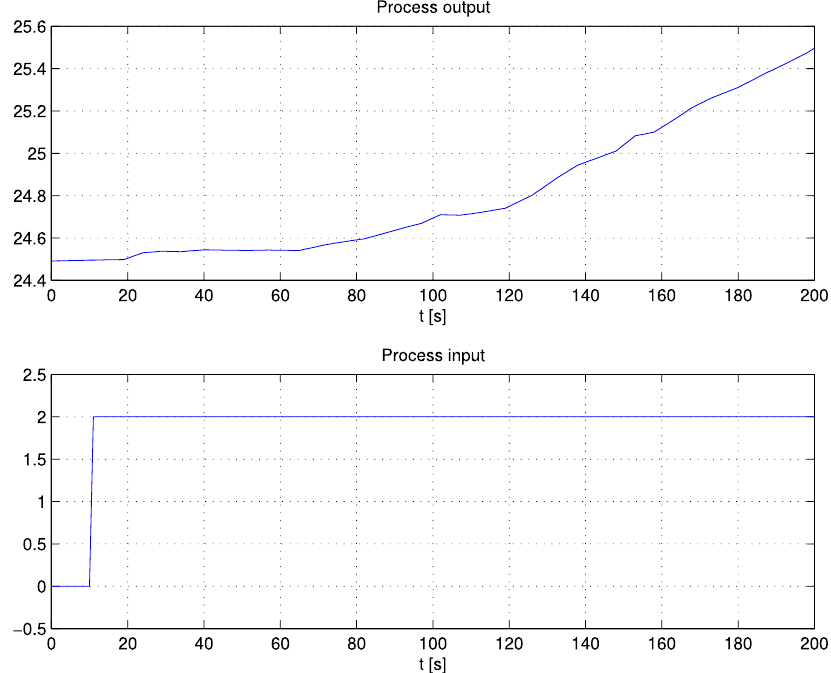
Figure 24. Process input (electric power in %) and output (temperature in °C) signals during manual experiment on autoclave within first 3 minutes.